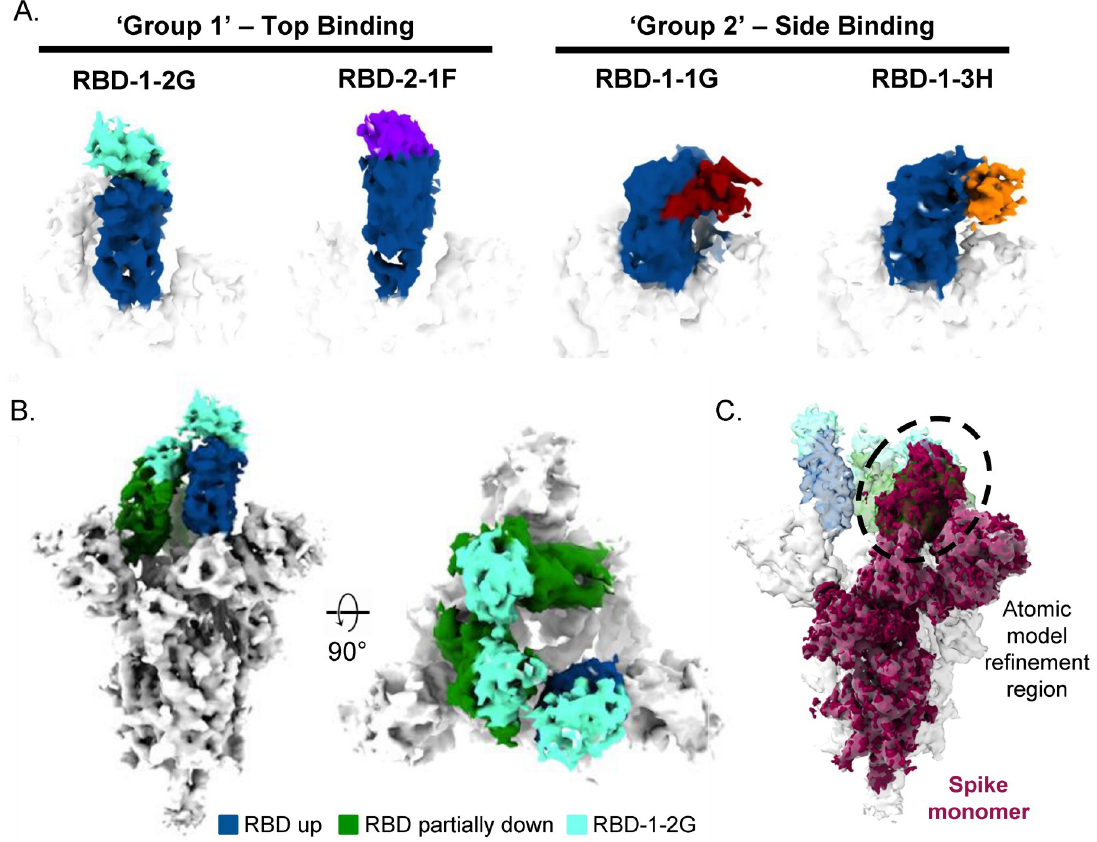
Fig 3. Cryo-EM of SARS-CoV-2 spike trimer and RBD binding nanobodies. (A) Cryo-EM analysis of nanobodies complexed with the RBD (up state) revealed two distinct binding modes. (B) Top and side views of the cryo-EM map of S-protein in complex with 3 molecules of RBD-1-2G (cyan). (C) Side view of the S-protein highlighting the spike monomer region refined during image processing is shown. The density containing the RBD in the laid state was used for the atomic model fitting